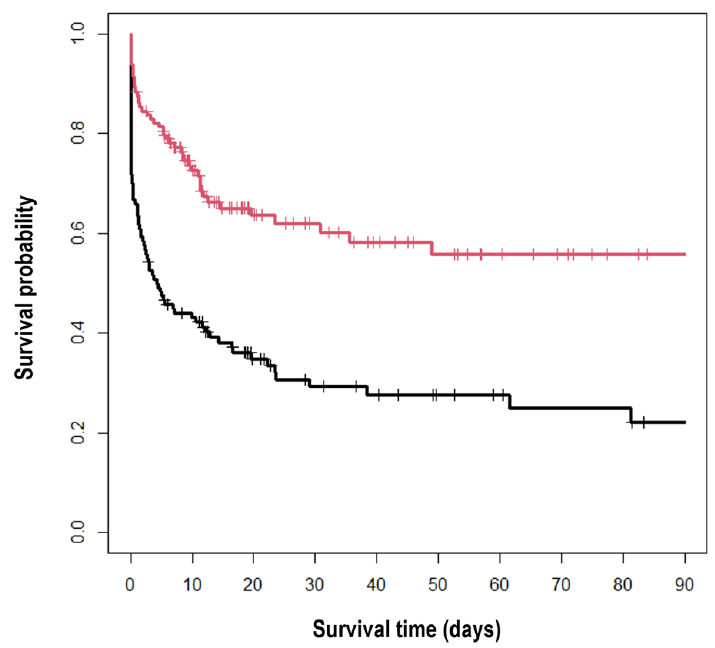
Figure 4. Kaplan Meier curves of 90 ‐ day mortality according to the average mean arterial pressure (MAP) during six hours. Red: average MAP ≥ 75 mmHg, black: average MAP < 75 mmHg ( p < 0.001).